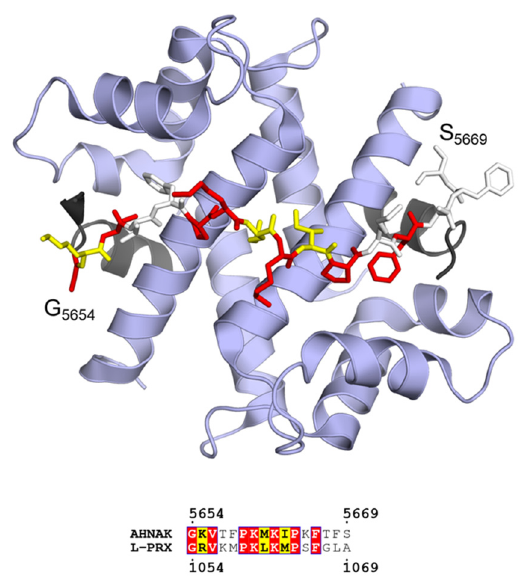
Figure 9. Ternary complex between AHNAK peptide (sticks), S100A10 (blue ribbon), and the acetylated N terminus of AnxA2 (black ribbon) in a 1:2:2 stoichiometry (PDB ID 4ftg [196]; top). Sequence alignment of the binding motif of AHNAK with L-PRX predicts a similar binding site in L-PRX (bottom). Coloring of the bound AHNAK peptide corresponds to residue conservation between AHNAK and L-PRX as evident from the sequence alignment.